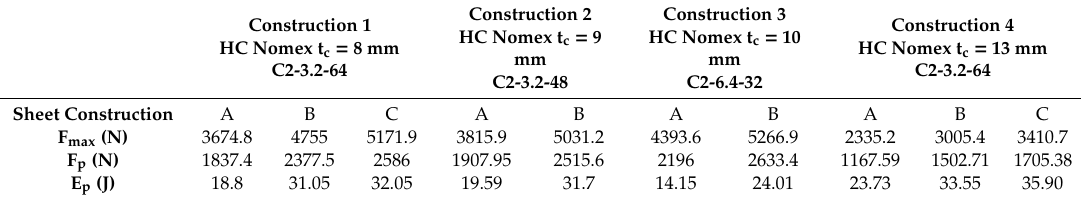
Table 6. Results of impact test with di ff erent Nomex